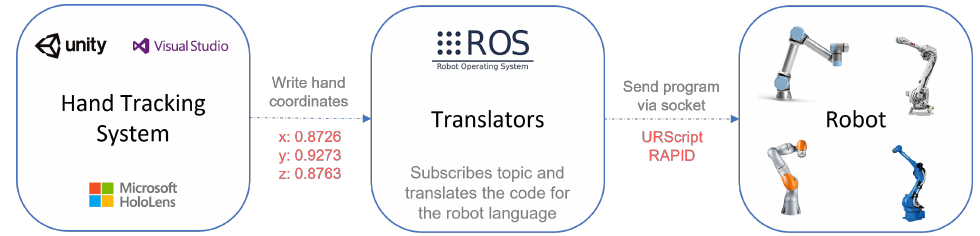
Figure 1. System’s